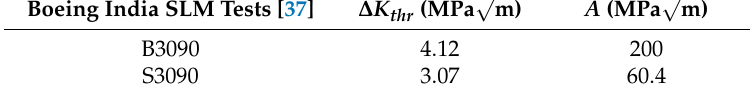
Figure 3. Measured crack growth in the Boeing India SLM specimens [37] compared with crack growth in the Bell Helicopter [35] and the LMwD [36] tests. Table 3. Values of ∆ K thr and A used in Figure 1 and identified by global optimization of Equation (4).